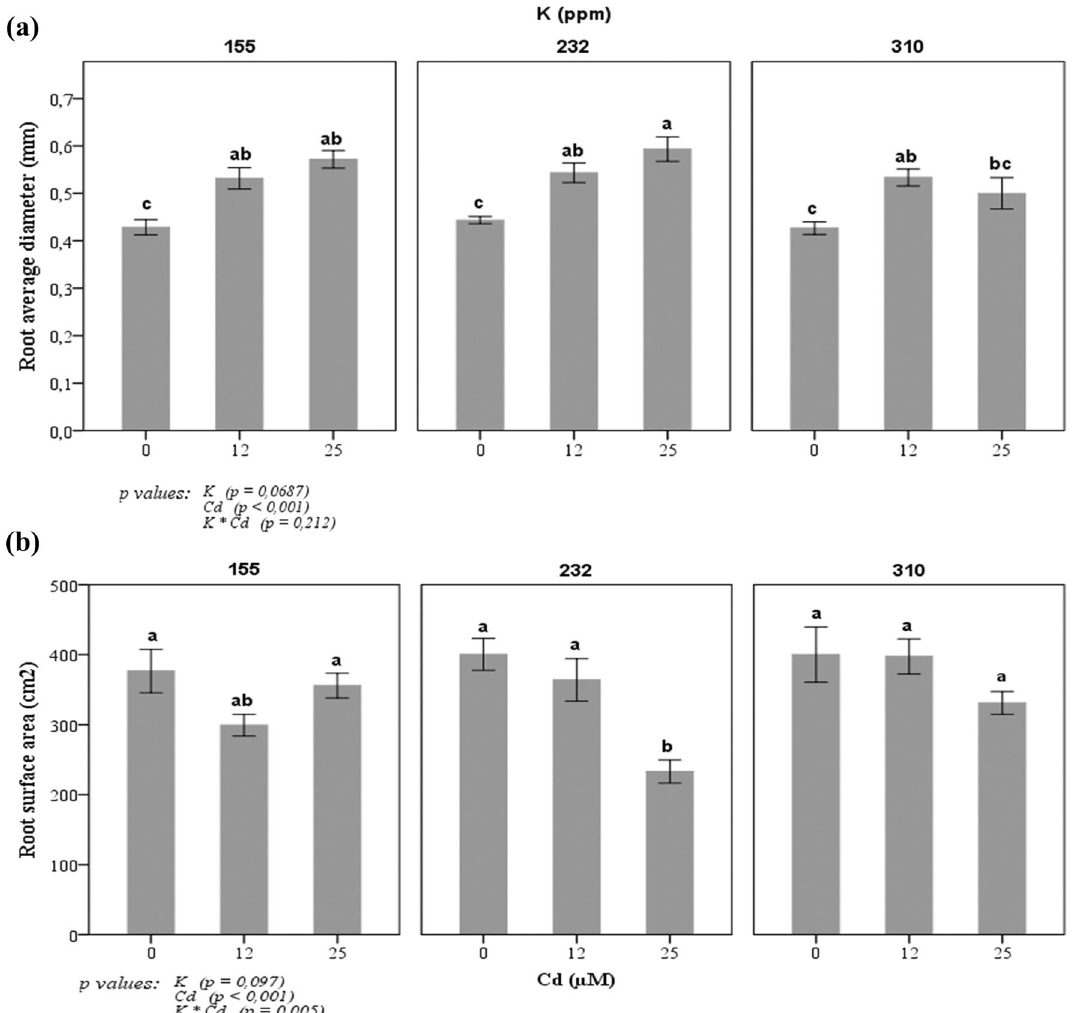
Figure 3. Changes in ( a ) root diameter and ( b ) root surface area (SA) of tomato plant in response to three potassium concentrations (155, 232, and 310 ppm) and three cadmium concentrations (0, 12 and 25 µM CdCl 2 ). Each value represents the mean ± SD of six independent repetitions, dissimilar letters indicate significant differences at p < 0.05 according to Student–Newman–Keuls